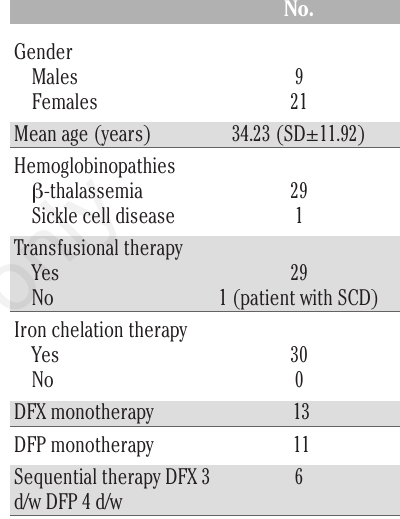
Table 1. Demographic and clinical features of the 30 studied patients.